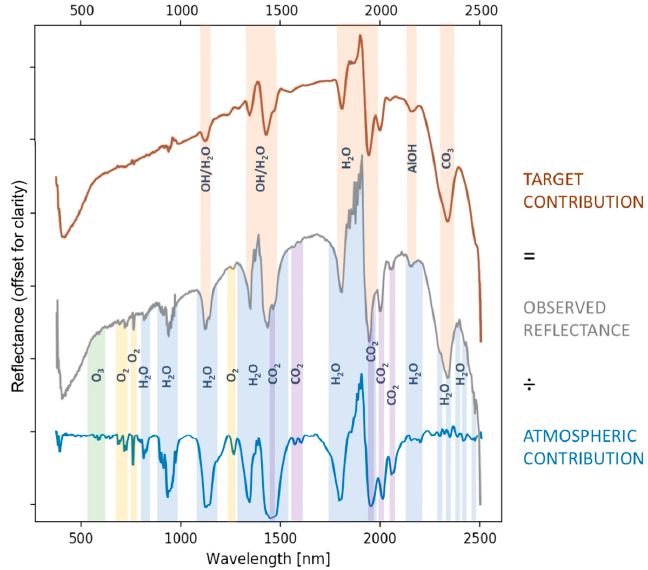
Figure 7. Contribution of geological target and atmosphere to an exemplaric observed reflectance spectrum (Nunngarut study area, Mârmorilik Formation). At this, the target contribution equals the reflectance spectrum after atmospheric correction.